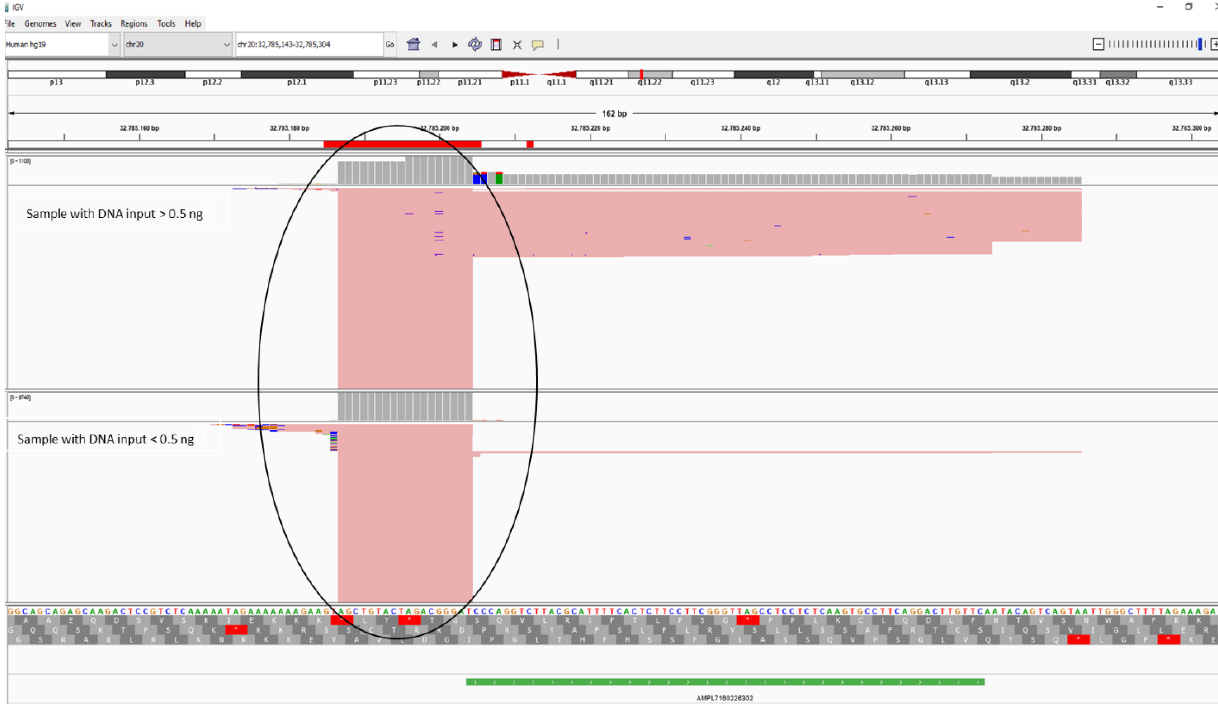
Figure 3. Visualization of sequence alignment to hg19 for AMPL7160226302 (rs6119471) with IGV software. In the circle, the dimers present in the